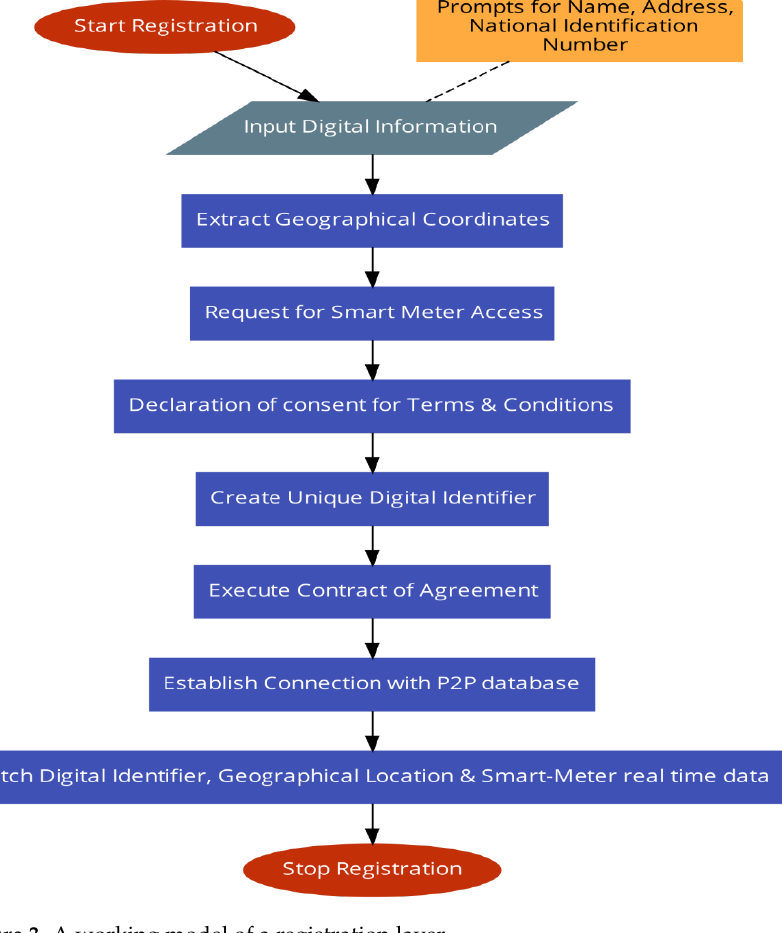
Figure 3. A working model of a registration layer .